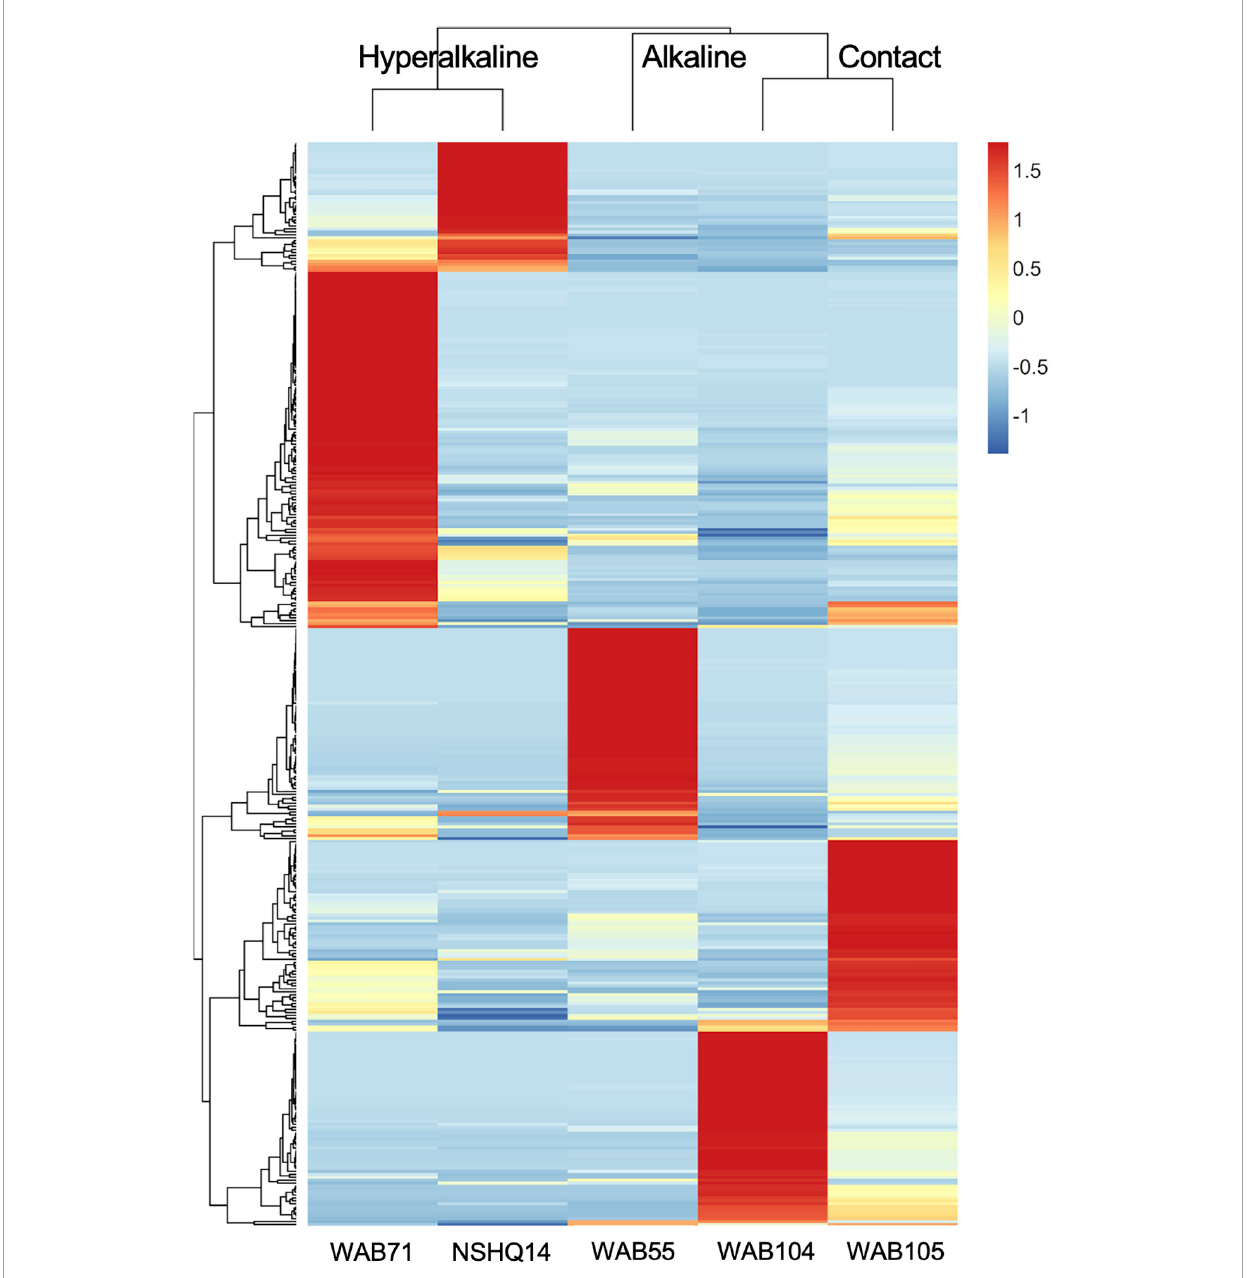
FIGURE3 Z-scores of bin abundance across wells, clustered using a Pearson correlation. Wells clustered according to fluid type: hyperalkaline (NSHQ14 and WAB71), alkaline (WAB104 and WAB105), and contact (WAB55). WAB71 had the greatest number of bins which were more abundant in this well than any other well, while NSHQ14 had the